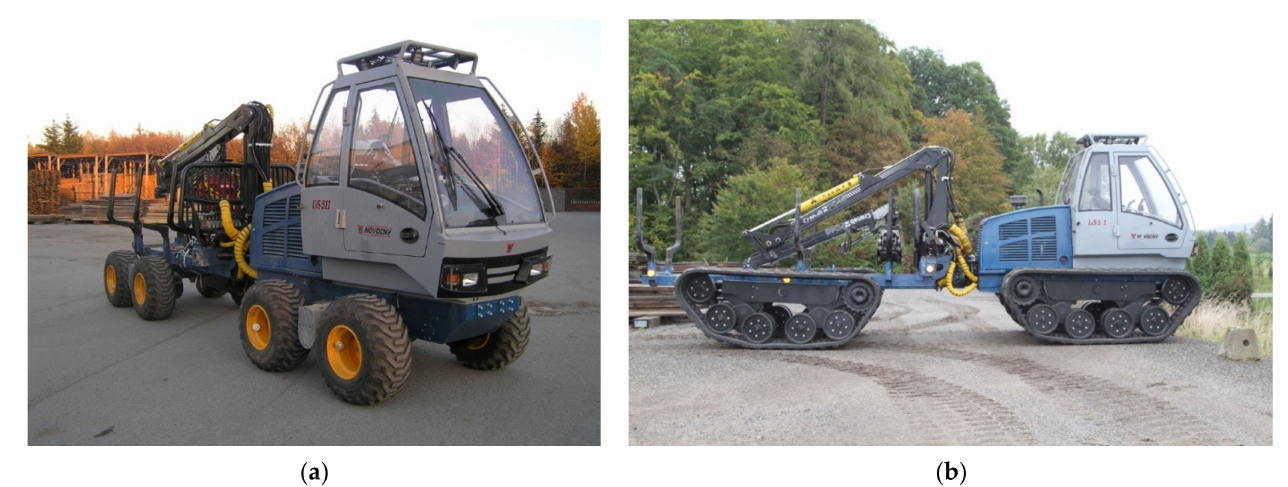
Figure 1. ( a ) Forwarder with the wheeled chassis; ( b ) forwarder with the tracked chassis. Contact areas of individual forwarder wheels at the given tire inflation were deter- mined experimentally by tire tread imprint on a large sheet of paper on the solid mat. Then, the outer boundaries of imprints were placed in a rectangle, and the area of this rectangle was considered as a simulation of the contact area of machine wheel with the soil surface after the sinking of tire tread pattern into the soil profile (Figure 2). This procedure was repeated five times and the resulting average value was determined as the arithmetic mean.